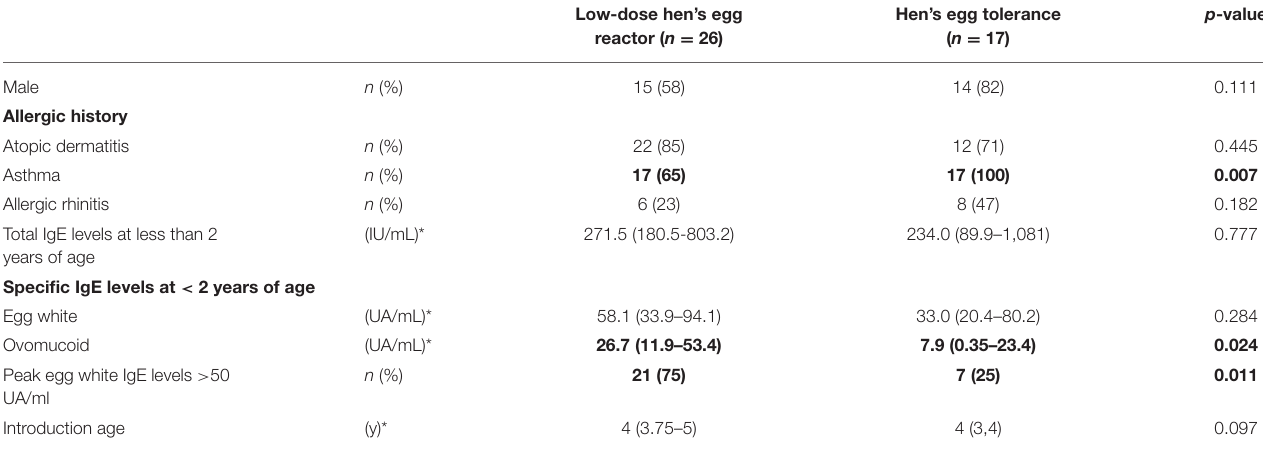
TABLE 1 | Clinical features of the two groups.